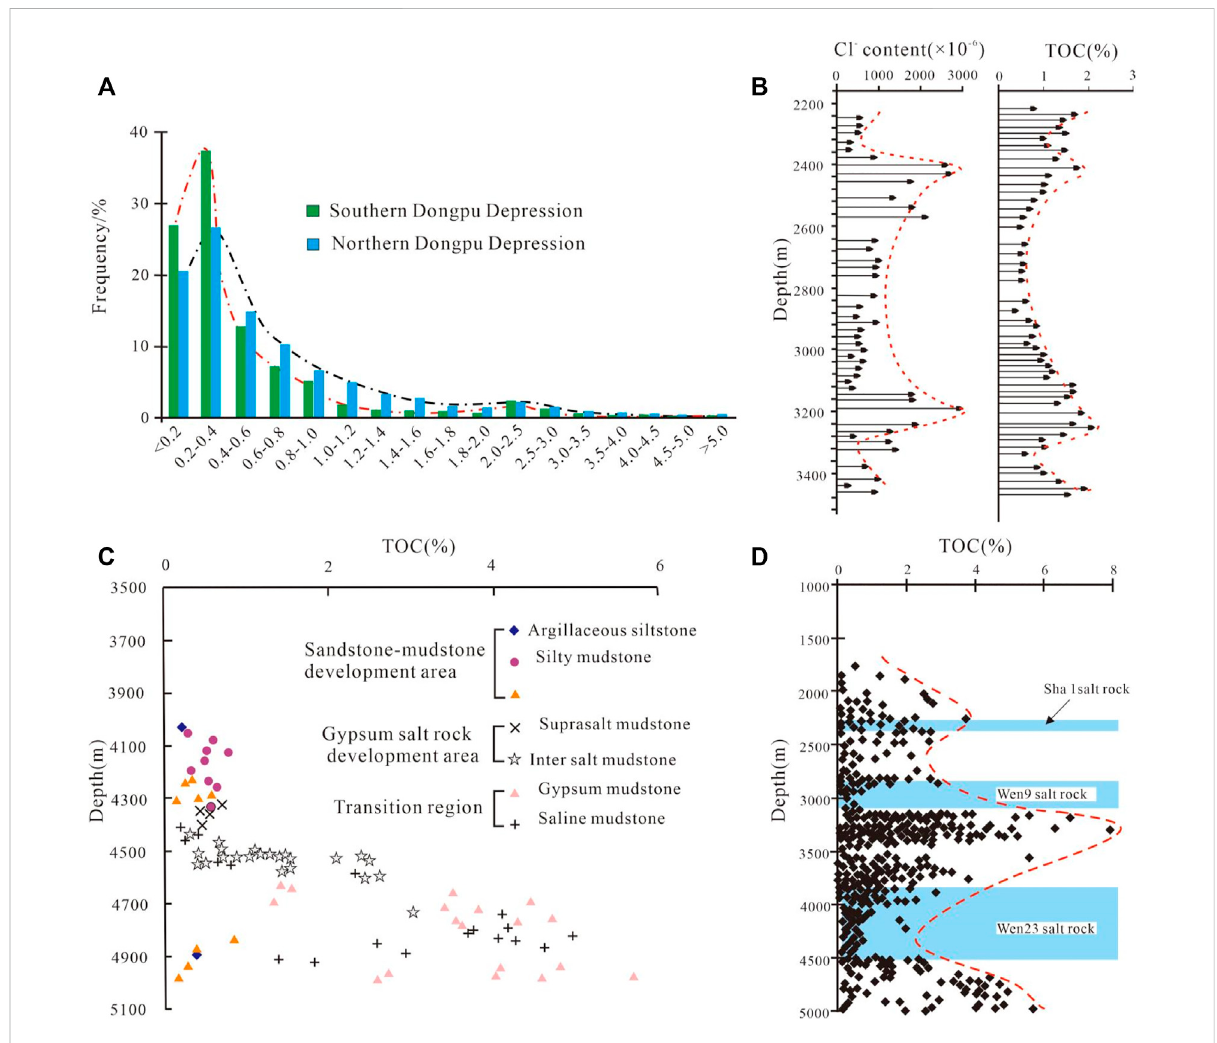
FIGURE 3 TOC content comparison of mud shales in Dongpu Depression of